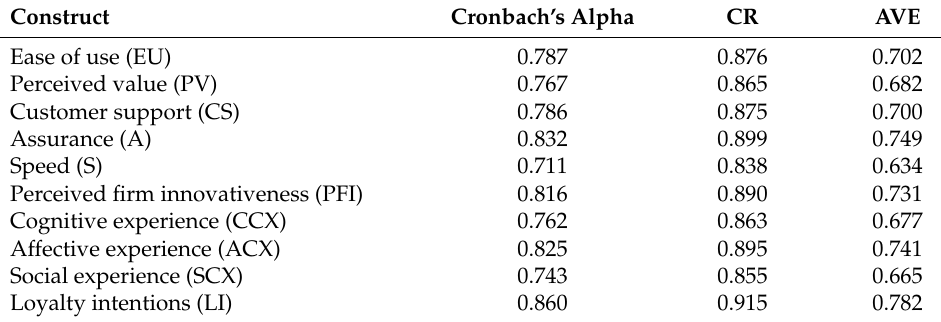
Table 3. The measurement model